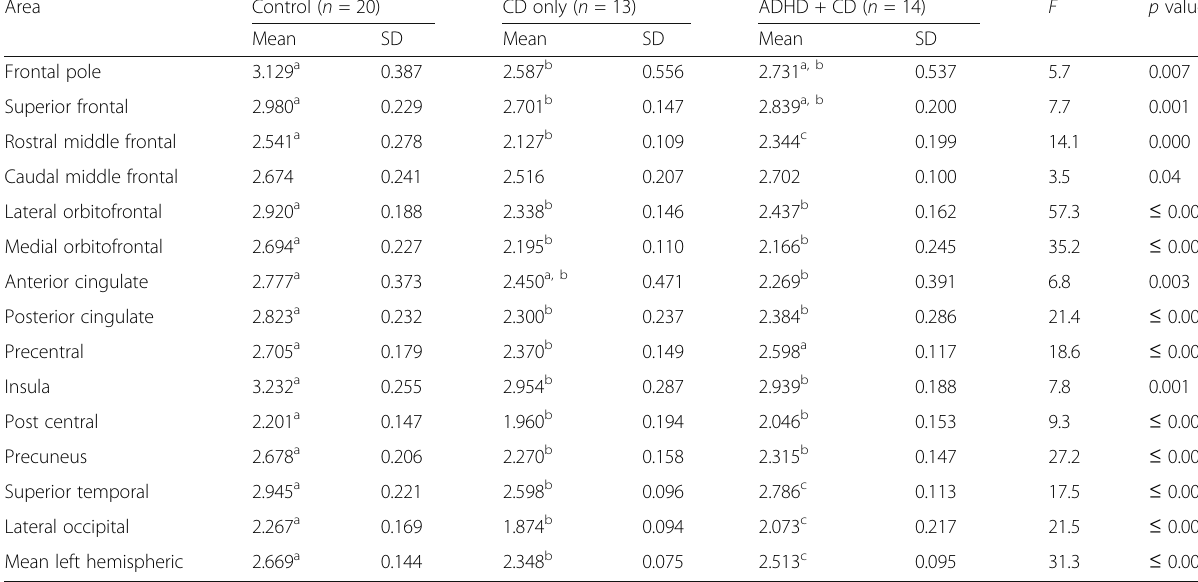
Table 3 Comparison between adolescents with conduct disorder, with and without ADHD, and control adolescents regarding left hemispheric cortical thickness (mm) Area Control ( n = 20)